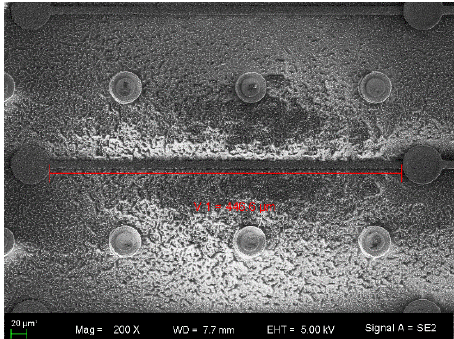
Figure 16. Morphology under SEM.